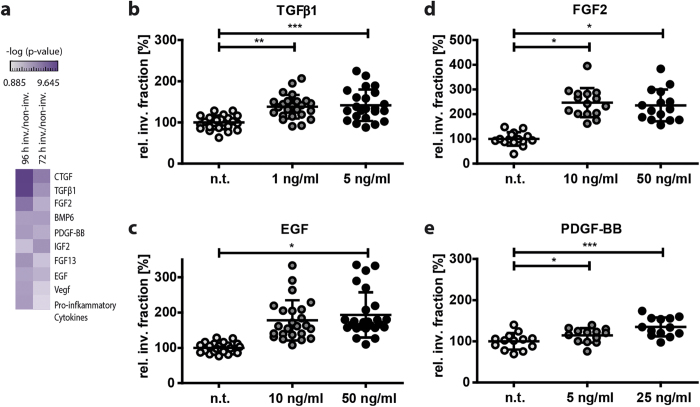
Causal network analysis, the identification and validation of pro-invasive growth-factors in the invasion signature of fibroblasts.A heatmap that indicates a ranking of physiological upstream regulators (filtered for ‘growth factors’) according to their p-values for gene expression data at 72 and 96 hours upon invasion (a). The predicted activated upstream regulators were functionally confirmed in vitro by a 3D invasion assay. Therefore, the invasive capacity of MLg fibroblasts was assessed by software-based quantification of the number of fibroblast nuclei (stained with DAPI) within and on top of the collagen matrix of 3D reconstructed confocal z-stacks. Fibroblasts were treated and left to invade the 3D collagen matrices for 48 hours. TGFβ1 (1 and 5 ng/ml), FGF2 (10 and 50 ng/ml), PDGF-BB (5 and 25 ng/ml) and EGF (10 and 50 ng/ml) were tested in the invasion assay (b-e). The data shown represent mean values (s.d.) from three to five independent experiment (n = 3–5) including five technical replicates each. (n.t. = non-treated). Statistical analysis: One way ANOVA with Dunnett’s multiple comparison test. *p < 0.05, **p < 0.01, and ***p < 0.001.